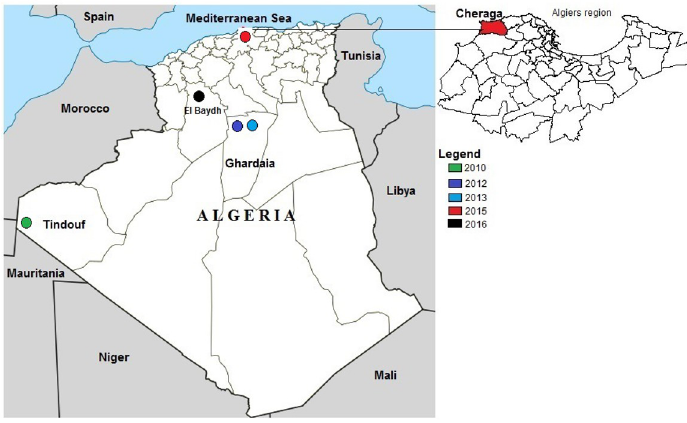
Fig 3. Map of locations of PPRV outbreaks in Algeria since 2010. Coloursindicateoutbreaksby year.